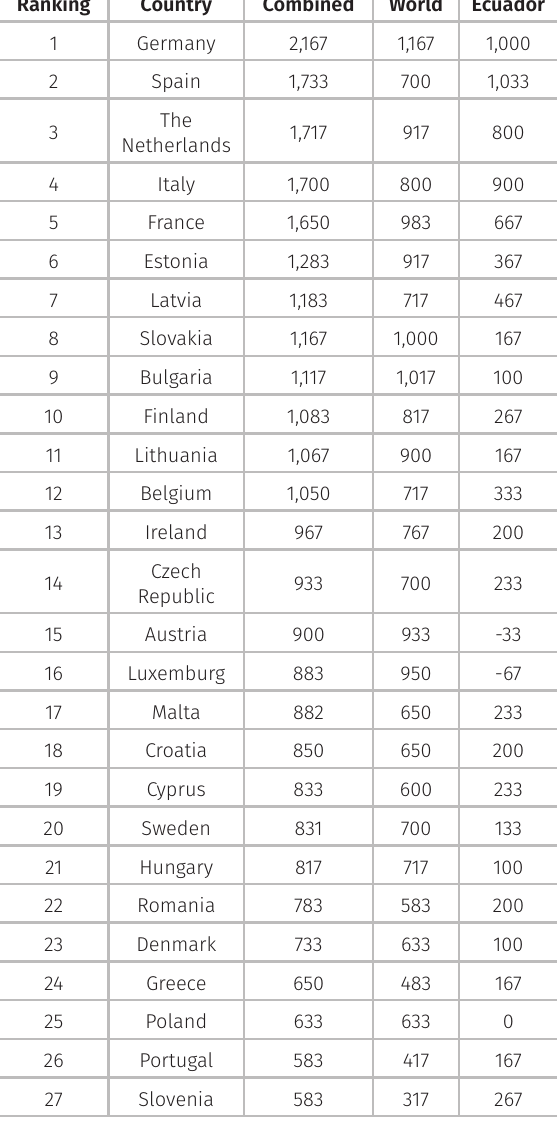
Table VIII. Ranking of the EU countries for Ecuadorian chia seed export market